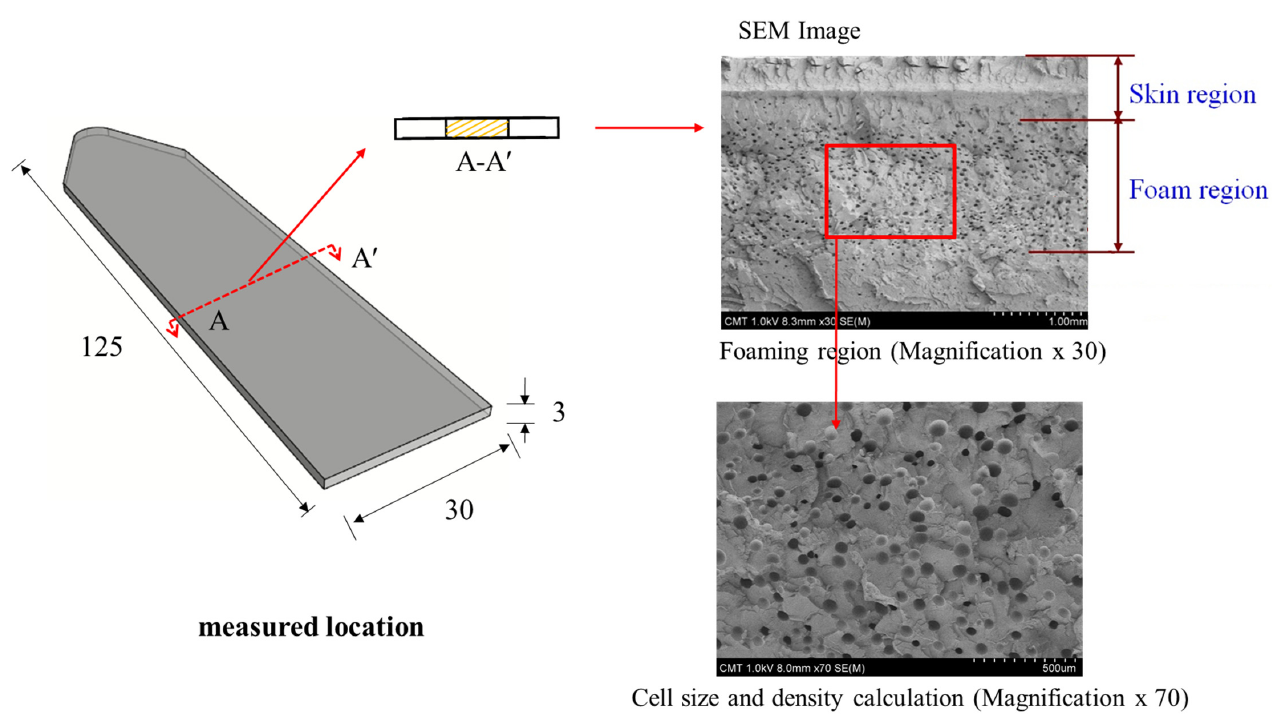
Figure 6. Measurement of the specimen at specified locations and the foaming bubble calculation of FE-SEM [26].